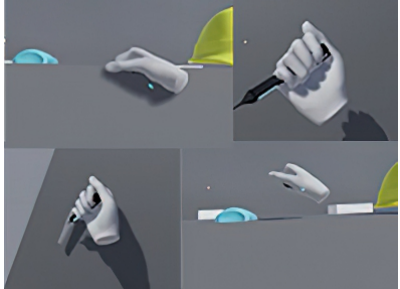
Figure 14. Electrical inspection in smart grid-training system.